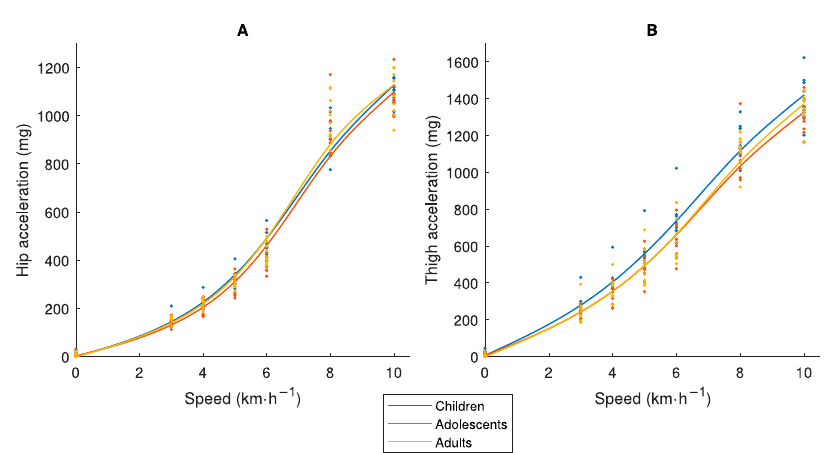
Figure 1. Relationship between absolute speed (Speed abs ) and the accelerometer measure of physical activity (PA) intensity (mg) for ( A ) hip and ( B ) thigh placement, in children 9–11, adolescents 14–16 and adults 23–44 years old.